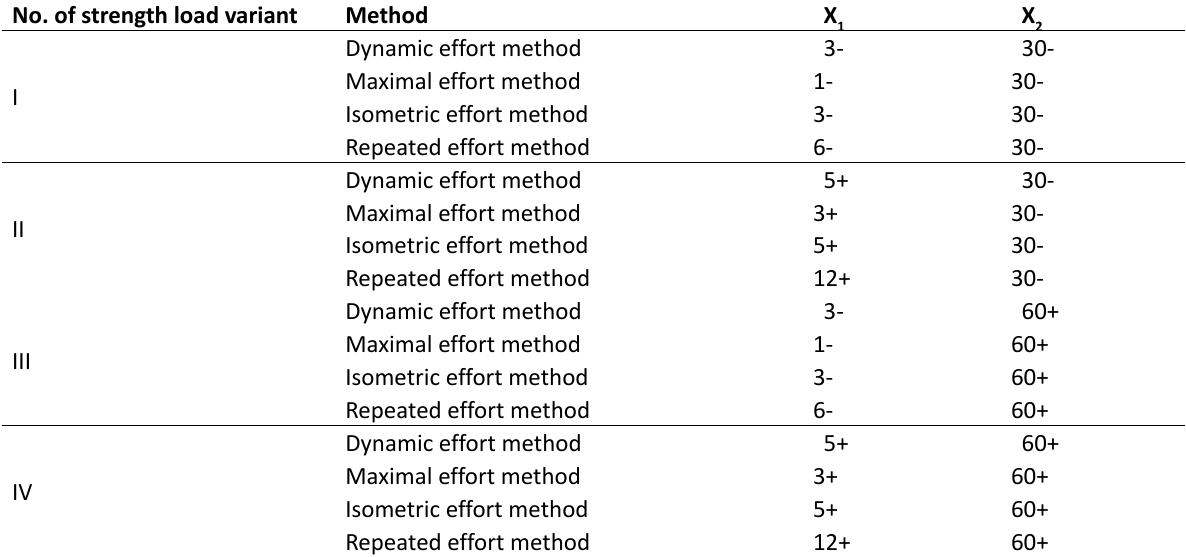
Table 1. Factorial design in studying the influence of different modes of the combined method of strength development (variant I) in primary schoolchildren (Х1 — number of repetitions in a set; Х2 — rest interval,